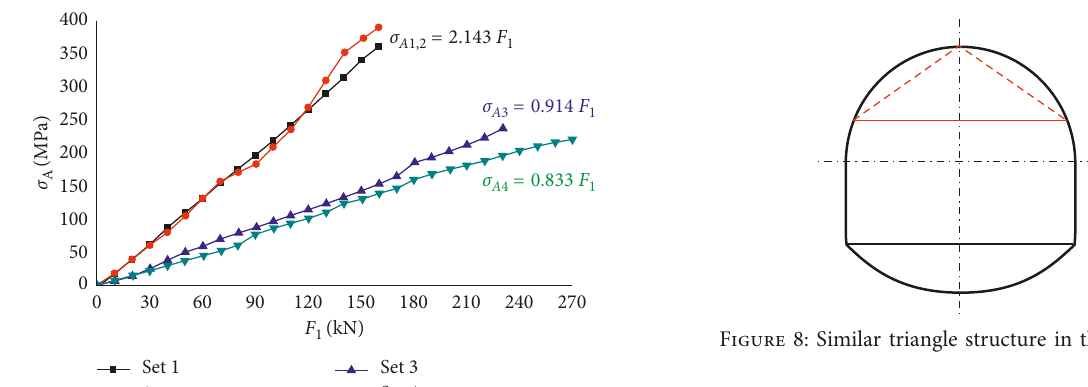
Figure 6: Results comparisons: (a) calculated results and experimental results of σ τ CI 12 . 6 .